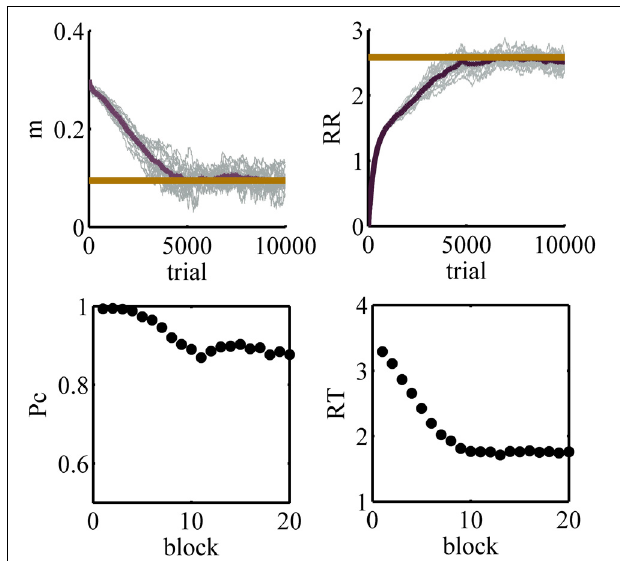
FIGURE 9 | Results of simulation 1. Top left: the value of the parameter m as a function of trial number during learning. Top right: the estimated average reward rate, ˆ ρ k , as a function of trial. In the top panels, the tick red line shows the optimal value. Bottom left: the accuracy as a function of block. Bottom right: the mean reaction time as a function of block. In the bottom panels, a block is defined as 500 trials. As learning progresses, the mean of the policy decreases and so the subject chooses lower decision thresholds more often. This leads to lower accuracy but faster responses.